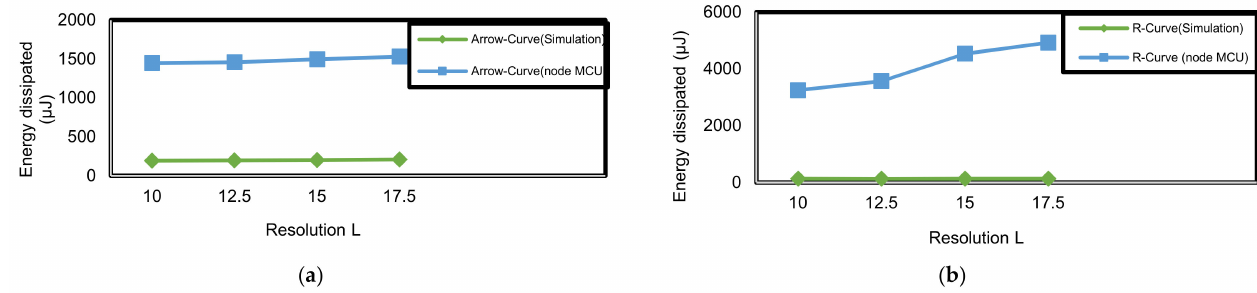
Figure 27. Energy dissipated ( µ J) corresponding to resolution (L) in both simulation and real environment: ( a ) Arrow-Curve path model; ( b ) R-Curve path model.